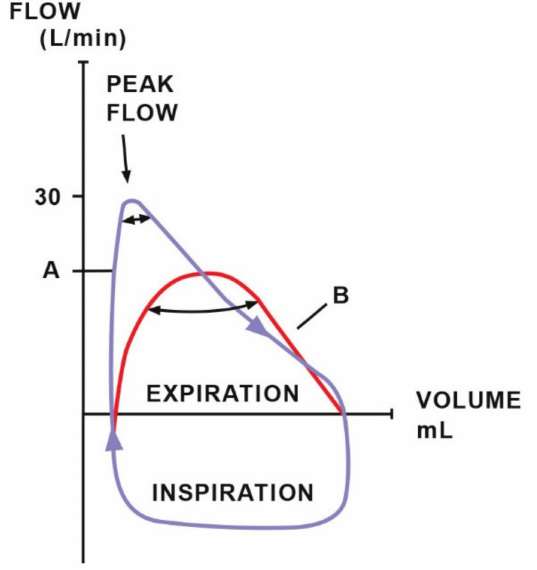
Figure 6. The resistance loop demonstrates the relationship between flow and volume. Loop A indicates typical resistance with a high peak flow. Loop B suggests increased airway resistance (decreased peak flow). Adapted with permission from [86] Copyright 2010 Y.P.S.